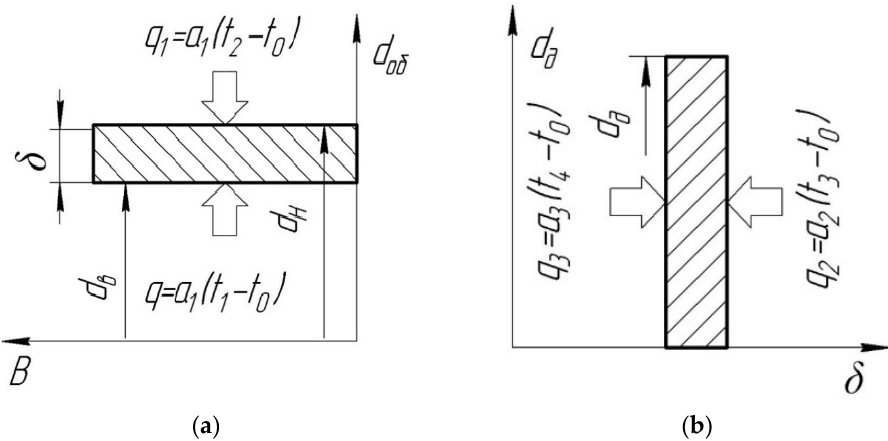
Figure 2. Design parameters of metal friction elements: ( a ) working surfaces of the pulley rim and drum; ( b ) surfaces of a solid-disc and heat fluxes generated on their working surfaces. In figure: d b , d H , d a —diameters: inner drum; outer pulley; solid disc; В , δ —width and thickness of elements; q i — heat fluxes; t i —surface temperatures; t 0 is the ambient temperature.